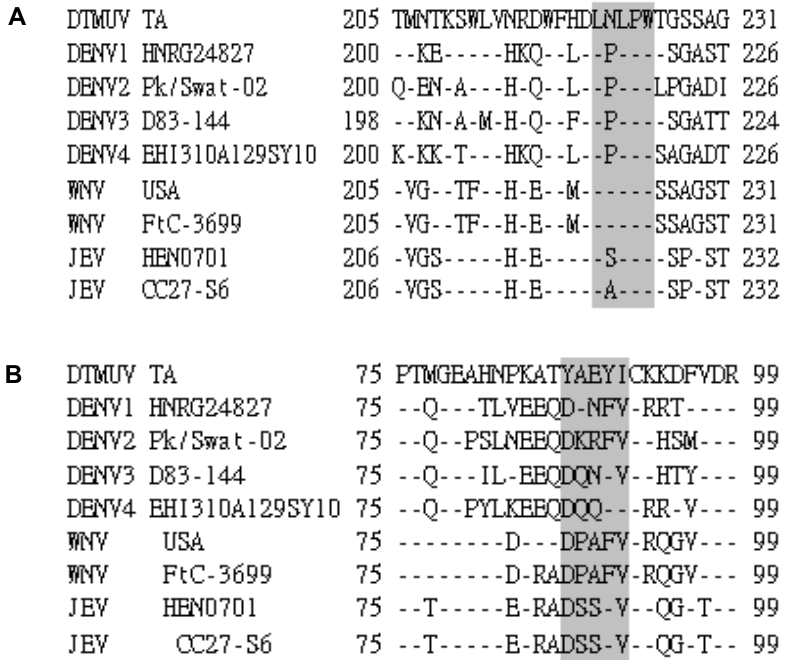
Figure 5. Sequence alignment of the epitope ‐ coding regions LNLPW ( A ) and YAEYI ( B ) in the flavivirus strain E proteins. The amino acid positions for each sequence are numbered on both sides. The DTMUV TA strain sequence is shown at the top; the dashes indicate identical amino acids. The identified epitope region is boxed in grey.